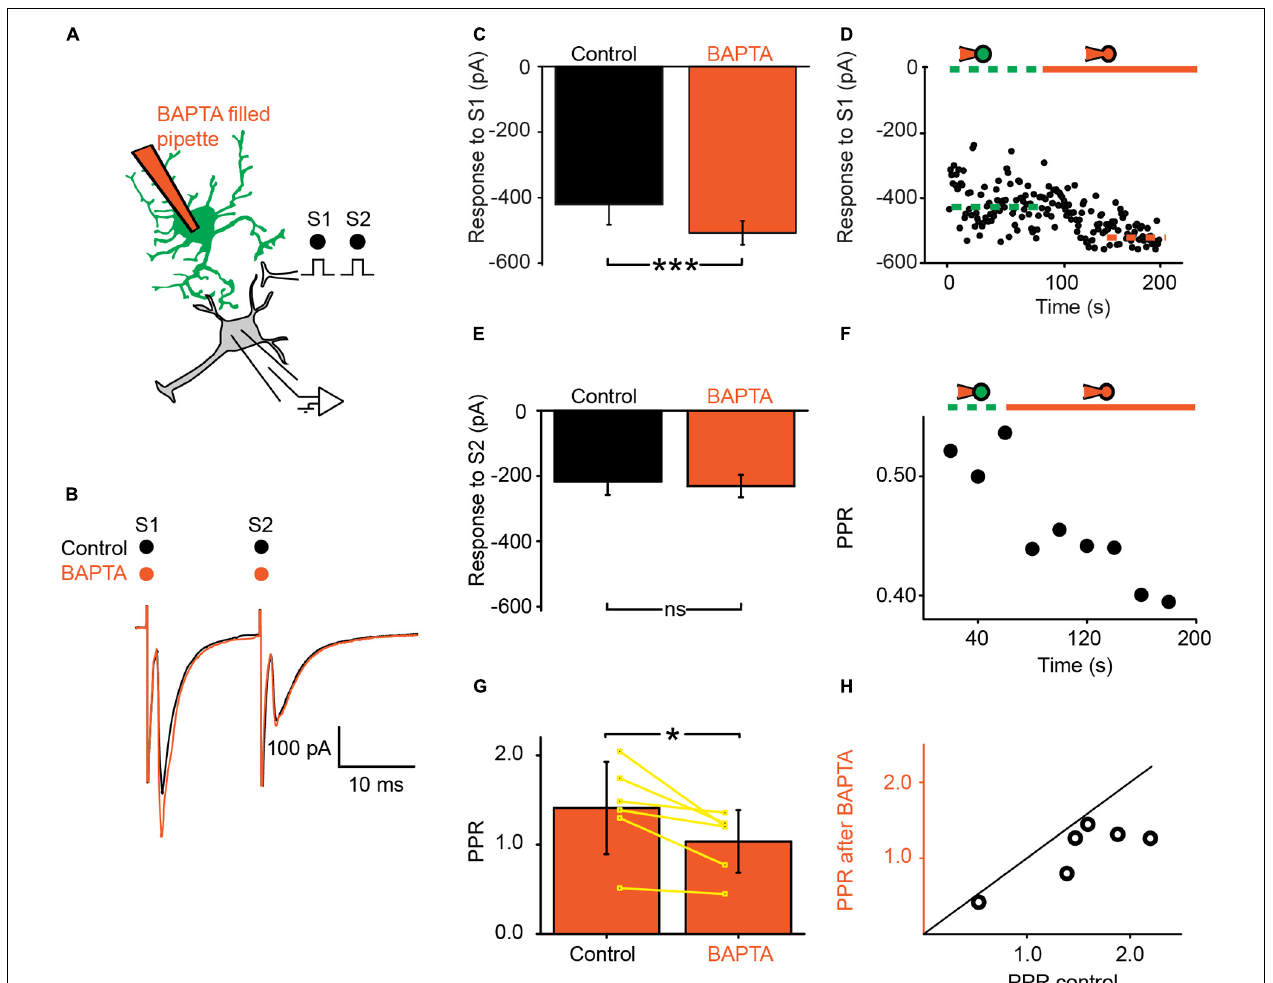
FIGURE 2 |Ventral horn astrocytes produce a tonic presynaptic inhibition of synaptic transmission. (A) Schema of the principle of the preparation. Ventral horn neuron recorded in whole-cell mode. Synaptic stimulation produced by a bipolar electrode (S1, S2). Whole-cell recording of an astrocyte with 30 mM BAPTA. (B) Response of a ventral horn neuron to two stimulations in control conditions (black) and after chelating Ca 2 + in one astrocyte (red). The amplitude of the first EPSC was increased. (C) Mean amplitude of the first EPSC in control condition and after chelating Ca 2 + in one astrocyte. The amplitude was significantly increased. ∗∗∗ p < 0.001. (D) Amplitude of the first EPSC when the astrocyte was recorded in cell-attached configuration (doted green line) and after breaking-in in whole-cell configuration (red line). Note the gradual increase